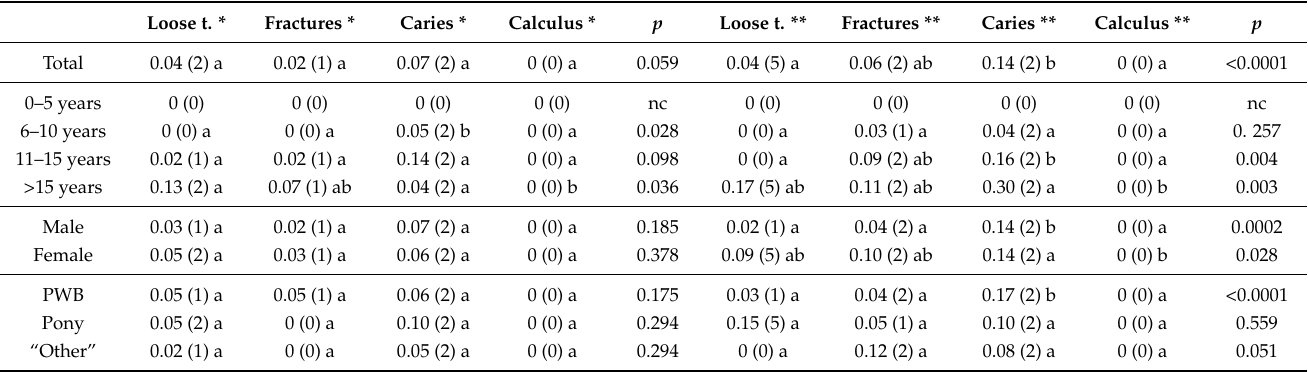
Table 10. The frequency distribution of dental diseases of premolar * and molar ** teeth in the total 7912 examined teeth of 206 horses.